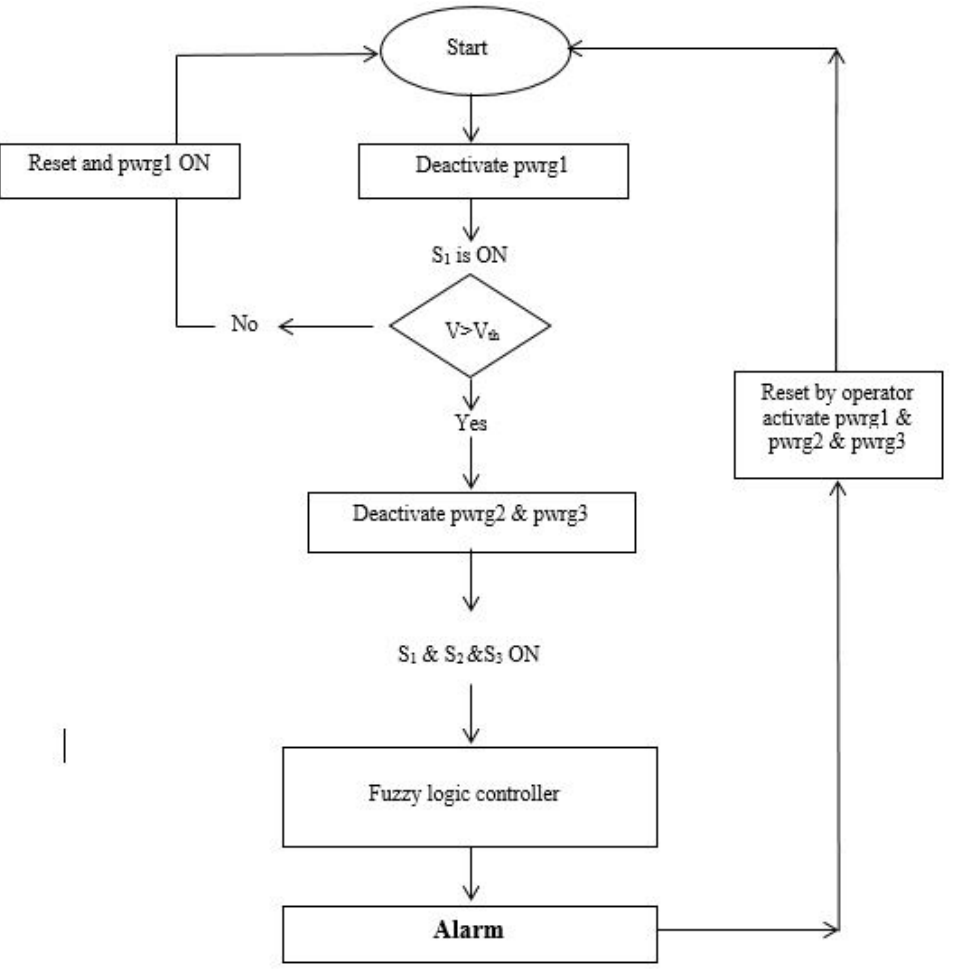
Figure 1. The algorithm of the